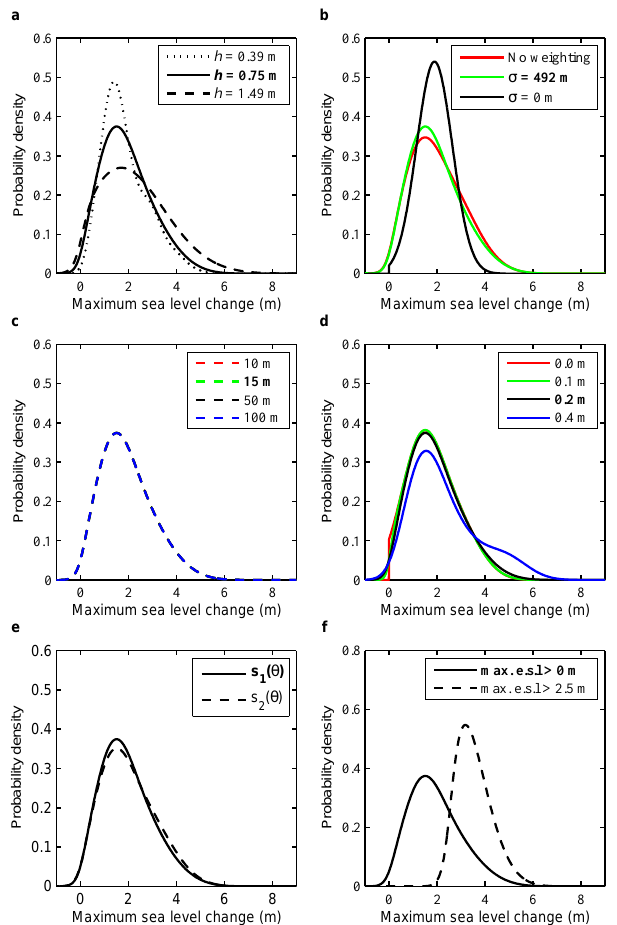
Fig. 11. Sensitivity of the LIG GrIS sea level contribution prob- ability density function to (a) the kernel smoothing parameter, h . Dotted line: optimal smoothing parameter according to Eq. (13). Solid line: smoothing parameter where modern-day observation is 2 σ from the ensemble mean (chosen as the most plausible case). Dashed line: smoothing parameter where modern-day observation is 1 σ from the ensemble mean. (b) The model error, σ , in Eq. (7). (c) Observational ice thickness error ( τ = 10, 15, 50 and 100m) from the Bamber et al. (2001) data set. The insensitivity of the resul- tant probability density function to the range in observational error tested means that the lines are indistinguishable from one another in the figure. (d) The logistic function given by Eq. (10) ( l w = 0 . 0, 0.1, 0.2 and 0.4m). (e) Comparison of two different methods of cal- culating the skill-score such that s 1 (θ) takes into account the error in ice thickness at each grid-point while s 2 (θ) uses the average ice thickness of the whole ice sheet. The parameters highlighted in bold are those used for the most plausible case shown in Fig. 10a. (f) The resultant probability density function (using the default parameters) when the constraint that the GrIS contributed at least 2.5m to global sea level (estimated from Kopp et al., 2009) is taken into account. A logistic function (with a width of 0.2m) on the lower tail of the probability density function is applied to constrain the minimum GrIS to sea level rise at 2.5m. The most plausible scenario is also shown by the solid line (note the different y-axis